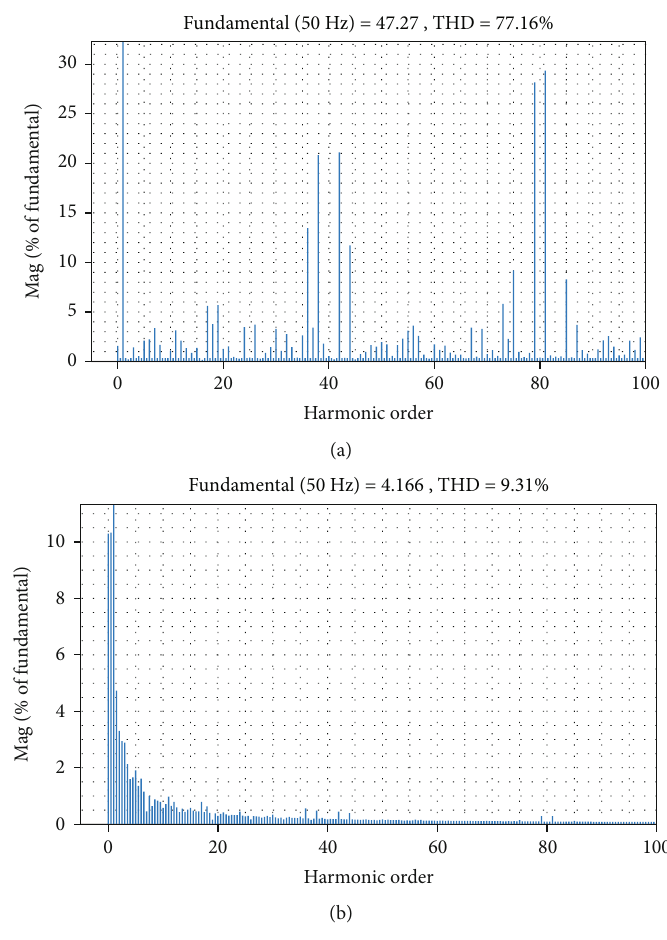
Figure 7: Spectrum of (a) Neutral voltages ( V